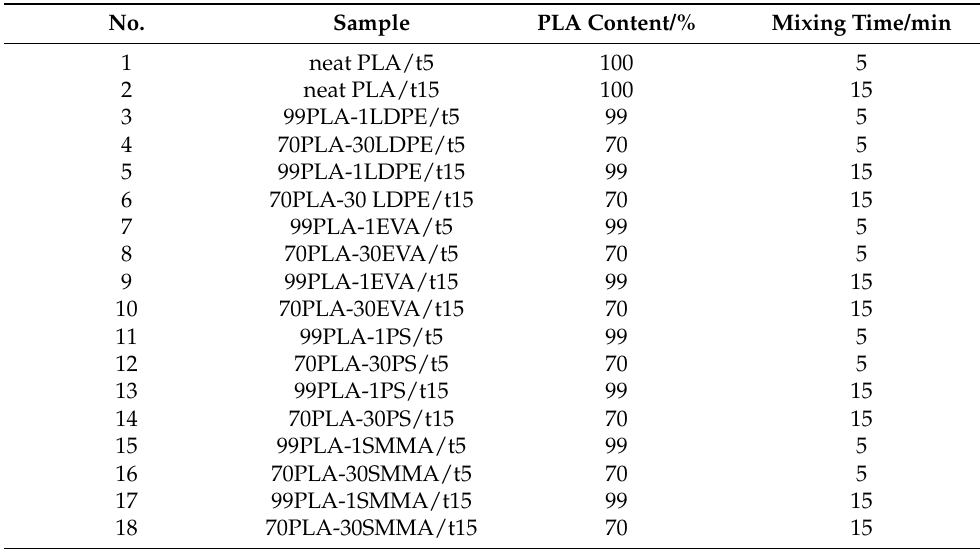
Table 1. Formulations of polymer blends produced. No. Sample PLA Content/% Mixing